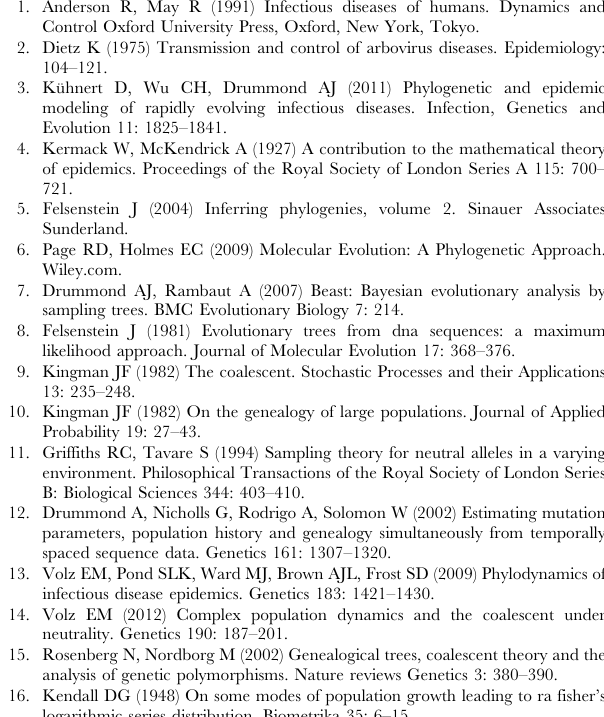
Table S3 Summary of growth rate parameter estima- tion statistics for trees with tips sampled at one point in time. For each of the 100 trees simulated under the birth-death model, with r ~ f 1,0 : 5,0 : 01 g and R 0 ~ f 128,1 : 1 g , we estimated the coverage, the 95% HPD interval sizes and the RMSE of r by the birth-death model and the coalescent model, and display the summary of these measures. (PDF) Supplementary Material S1 First part describes the derivation of waiting times until coalescent under discrete time Wright-Fisher, discrete time Moran, and continuous time Wright-Fisher and Moran population models. Second part discusses parameter correlations under the birth-death process. (PDF) File S1 An example xml file for simulation of coalescent trees, using sampling times from the birth-death process, by sampling from the coalescent tree prior in BEAST v2.0 is provided.